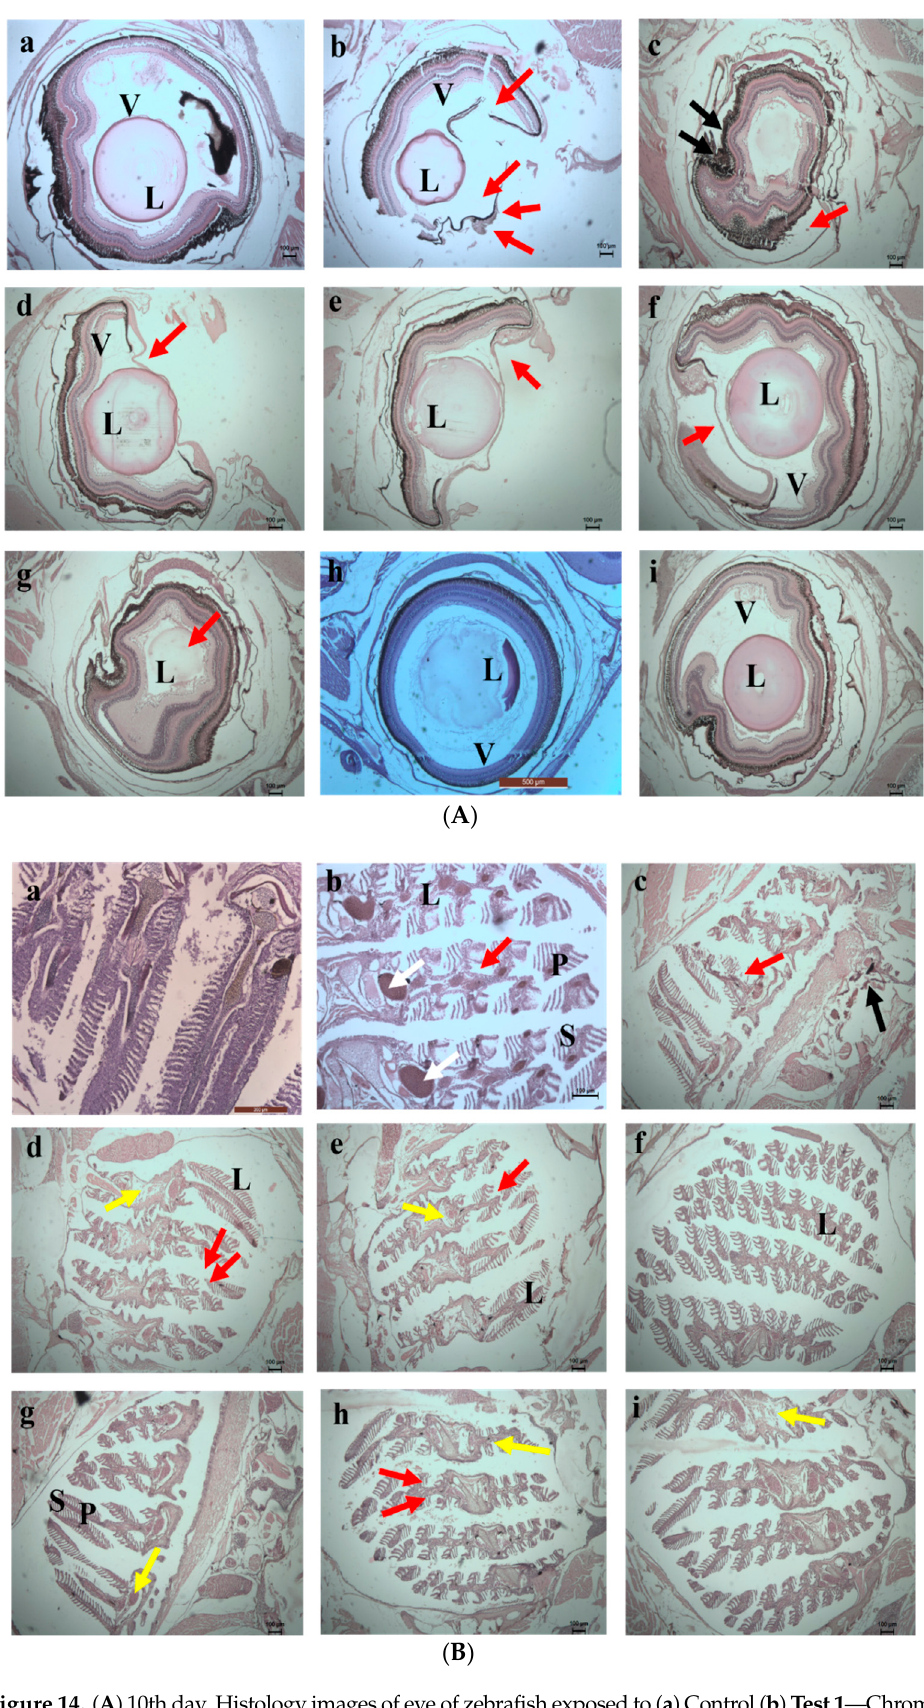
Figure 14. ( A ) 10th day. Histology images of eye of zebrafish exposed to ( a ) Control ( b ) Test 1 — Chromium metal in water ( c ) Test 2 —SPIONs in water ( d ) Test 3 —Chromium metal with water in SPIONs ( e ) Test 4 —Chromium metal in water with SPIONs removed after interaction for 1 h ( f ) Test 5 —Chromium metal in water with alginate–SPIONs microspheres ( g ) Test 6 —Chromium metal in water with alginate–SPIONs microspheres removed after interaction for 1 h ( h ) Test 7 — Chromium metal in water with alginate beads ( i ) Test 8 —Chromium metal in water with alginate beads removed after interaction for 1 h. (Red arrow denotes erosion; L—Lens, V—Vitreous). ( B ) 10th day. Histology images of gills of zebrafish exposed to ( a ) Control ( b ) Test 1 —Chromium metal in water ( c ) Test 2 —SPIONs in water ( d ) Test 3 —Chromium metal with water in SPIONs ( e ) Test 4 —Chromium metal in water with SPIONs removed after interaction for 1 h ( f ) Test 5 — Chromium metal in water with alginate–SPIONs microspheres ( g ) Test 6 —Chromium metal in water with alginate–SPIONs microspheres removed after interaction for 1 h ( h ) Test 7 —Chro- mium metal in water with alginate beads ( i ) Test 8 —Chromium metal in water with alginate beads removed after interaction for 1 h. (Red arrow denotes erosion, Yellow arrow denotes the intestinal space; Black arrow denotes deposition; White arrow denotes Lipofuscin (P—Primary Lamella, S—Secondary Lamella, L—Lamella). 3.3.2. Inductively Coupled Plasma—Mass Spectrometry (ICP—MS) The accumulation of chromium and the iron in fish was evaluated using ICP—MS analysis (Figures 15 and 16). From the analysis, the highest accumulation of chromium was observed only in Test 1 at a concentration of 0.96–0.97 mg/kg, then in Test 3, whereas fishes in other tests were found to have negligible concentrations of chromium accumula- tion. The accumulation of iron was also estimated, and it was recorded in fishes in Tests 3 to 7. The highest concentration, of 0.71 mg/kg, was recorded in the fish grown in Test 3 and may have arisen from dispersion of SPIONs from alginate beads.